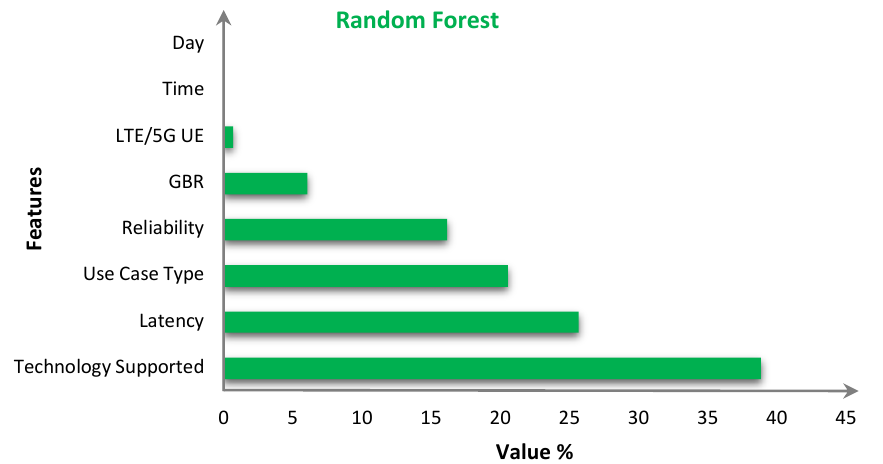
Figure 5. Feature Importance of Random Forest Algorithm.